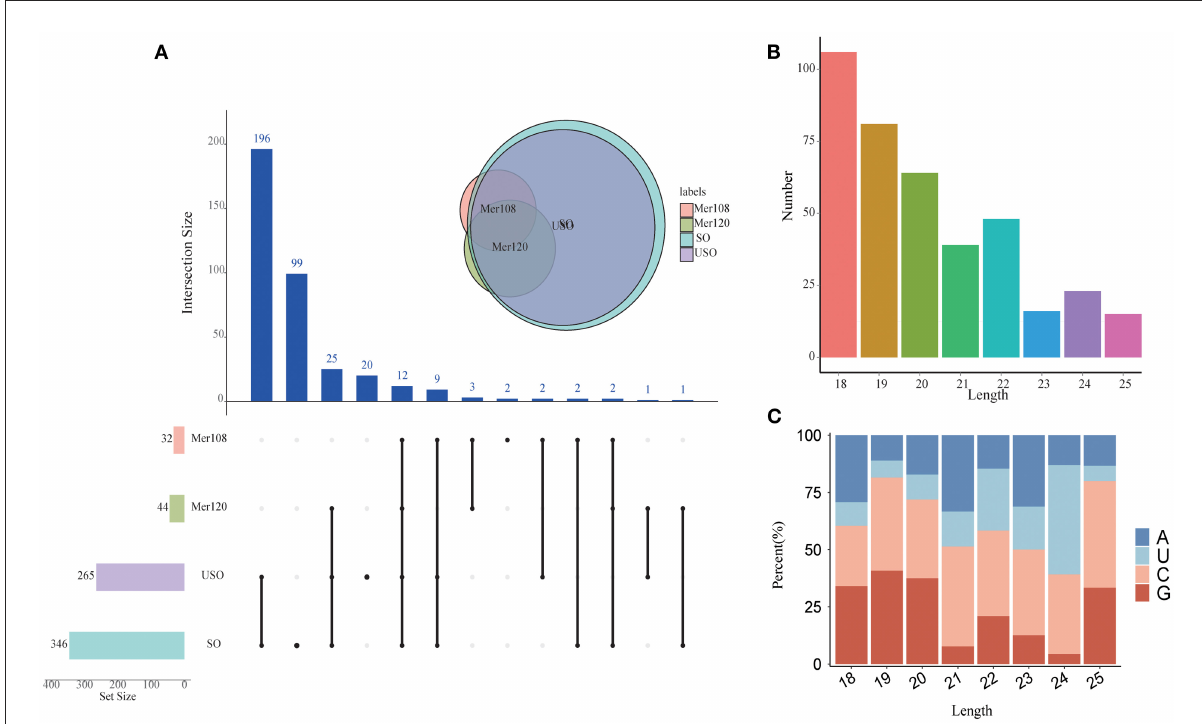
FIGURE2 Characterization of the novel miRNAs in E. tenella . (A) An UpSet plot showing the set of all miRNAs from four different developmental stages. Vertical bars show the number of intersecting miRNAs between stages, denoted by the connected black circles below the histogram. The horizontal bars show the size of the transcript sets between stages. The Venn diagram shows the numbers and overlapping situation of miRNAs with different transcripts in different groups. (B) Length distribution of the novel E. tenella miRNAs. (C) Codon usage preference of the first base of E. tenella miRNAs of different